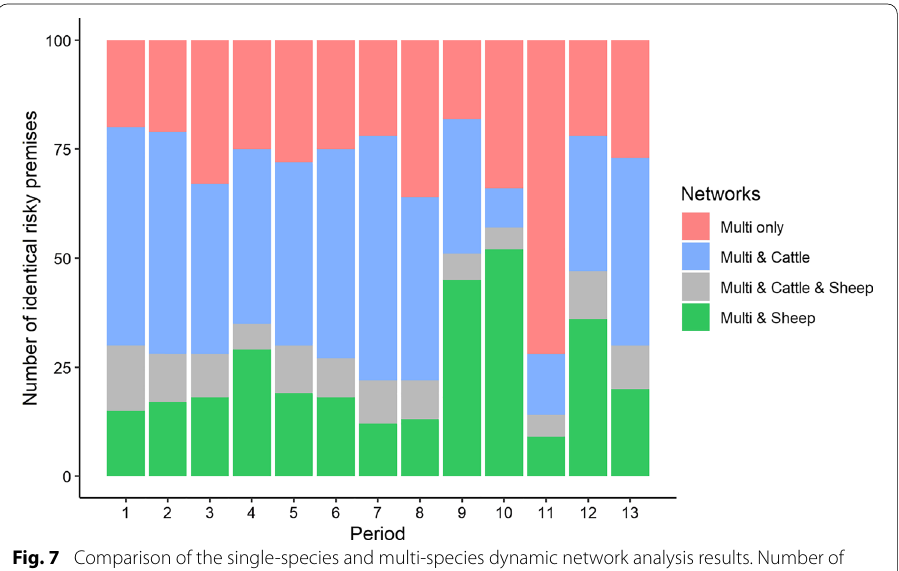
Fig. 7 Comparison of the single‑species and multi‑species dynamic network analysis results. Number of identical risky premises between networks after ranking premises according to geometric mean contact chains. In grey is shown the number of premises which are risky in the multi‑species, the sheep, and the cattle networks, in blue and in green is shown the number of premises risky in the multi‑species and the cattle network but not in the sheep network, and the multi‑species and the sheep, but not in the cattle network respectively; the red area represents the premises which are risky in the multi‑species network